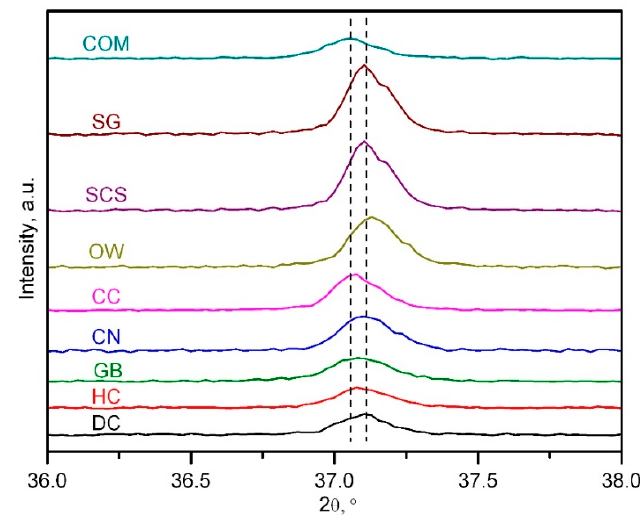
Figure 2. Close-up view of the XRD patterns of the bulk Co 3 O 4 catalysts in the 36–38° range.